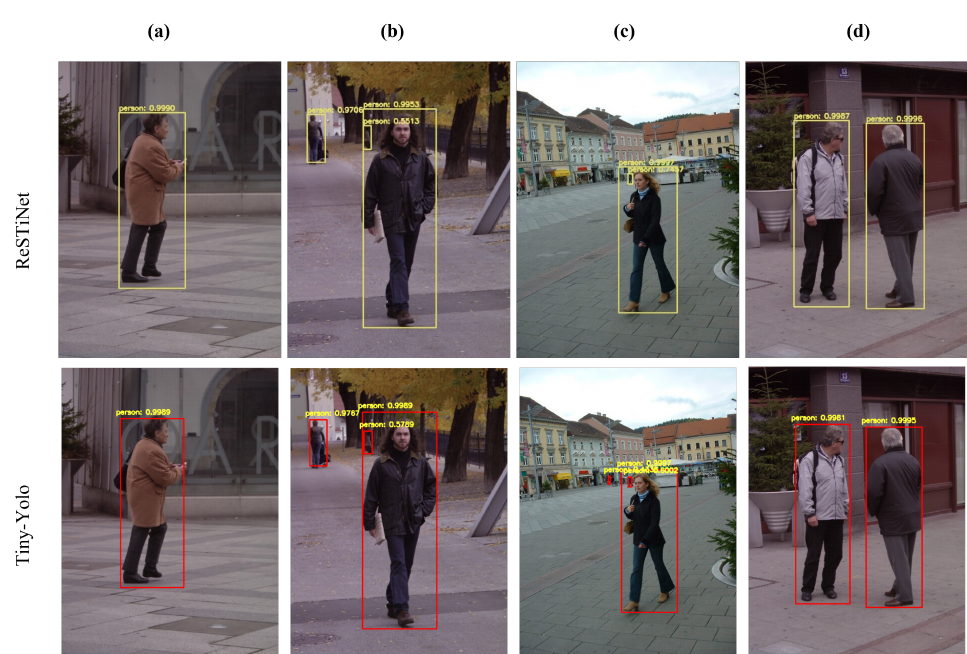
Figure 6. Detection results with confidence values for the proposed ReSTiNet and Tiny-YOLO model in a sparse scenario. ( a – d ) presents comparison for four images for the models.